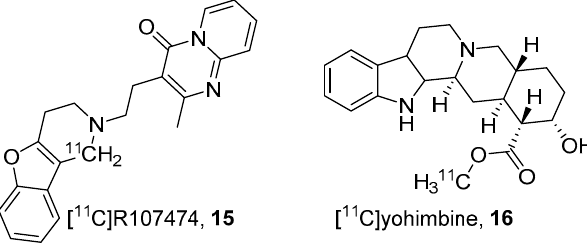
Figure 3. Anti-depressive & antihypertensive based α 2-AR PET radiotracers .